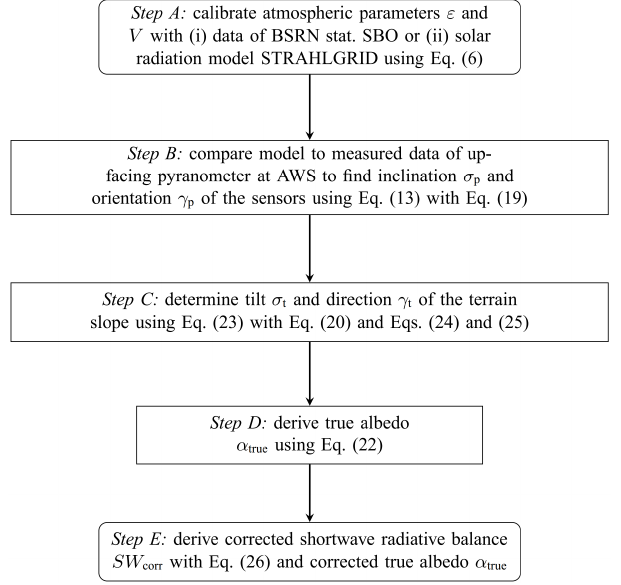
day in an ideal case and σ t and γ t fit the measured data of the reflected measured radiation F ↑ , calculated with Eq. (23).